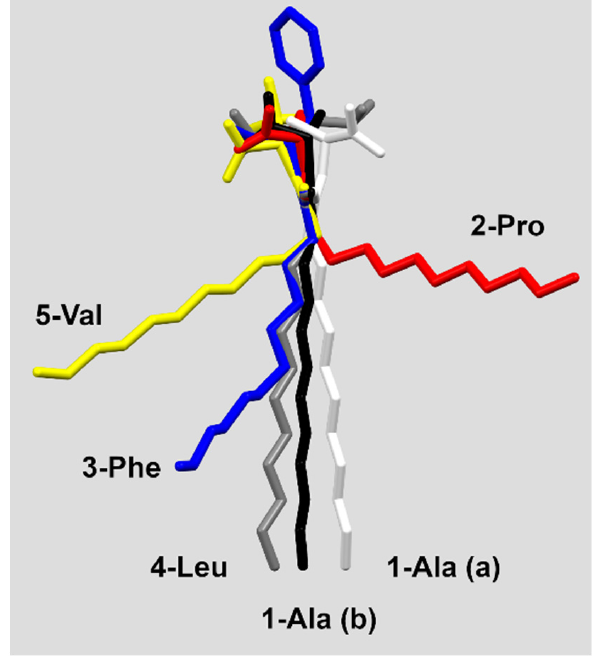
Figure 2. Conformation differences in the studied molecules. The separation of hydrophilic and lipophilic regions (Figure 3) which may favor the gelation process occurs in a special way. The connection between gelling ability of some amino acid surfactants and 2-dimensional packing type was considered previously by Bastiat and Leroux [22]. To study such potential relationships, in the crystal packing anal- ysis we decided to complement the study by the energy framework calculations.